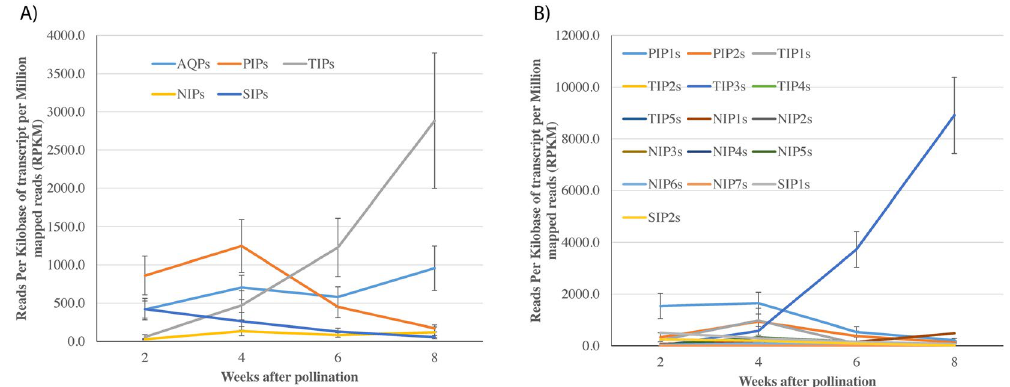
Figure 6. Expression of Brassica napus AQP in developing seeds. RNA-seq expression data available (Bioproject PRJNA311067) for B . napus seed at 2, 4, 6, and 8 weeks after pollination was used for AQP expression profiling. Graphs are showing expression level in term of average reads per kilobases of transcript per million mapped reads (RPKM) for ( A ) four AQP subfamilies namely PIP, Plasma membrane intrinsic protein; TIP, Tonoplast intrinsic protein; NIP, Noduline-26 like intrinsic protein; SIP, Small intrinsic protein; and ( B ) groups in each subfamily. Bars represent standard error from the mean for all values within a subfamily or a group. Detailed data are provided in Supplementary Dataset 4.